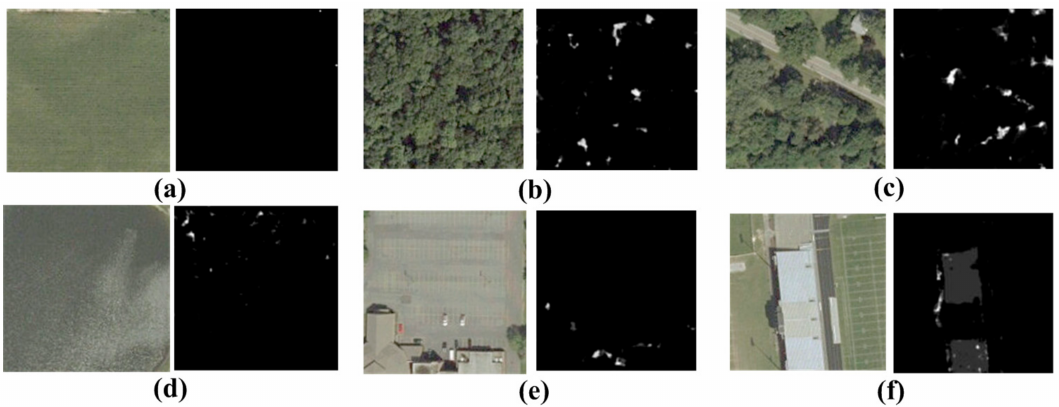
Figure 23. Several examples of different categories misclassified by the color-boosted saliency-guided rotation invariant BOVW representation with parameter transfer in the SIRI-WHU dataset: ( a ) farmland, ( b ) forest, ( c ) freeway, ( d ) other, ( e ) parking lot, and ( g )